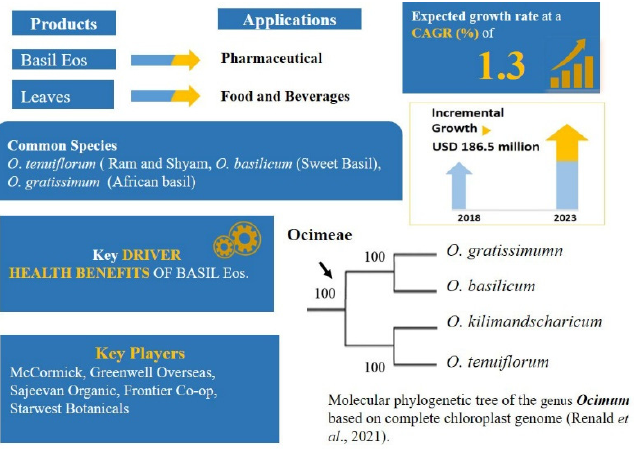
Figure 4. Basil products market analysis [194] and phylogenetic relationship among the species.